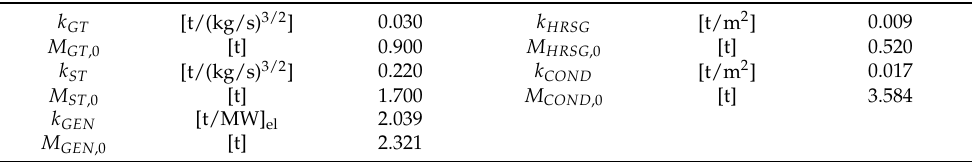
Table 5. Parameters for weight